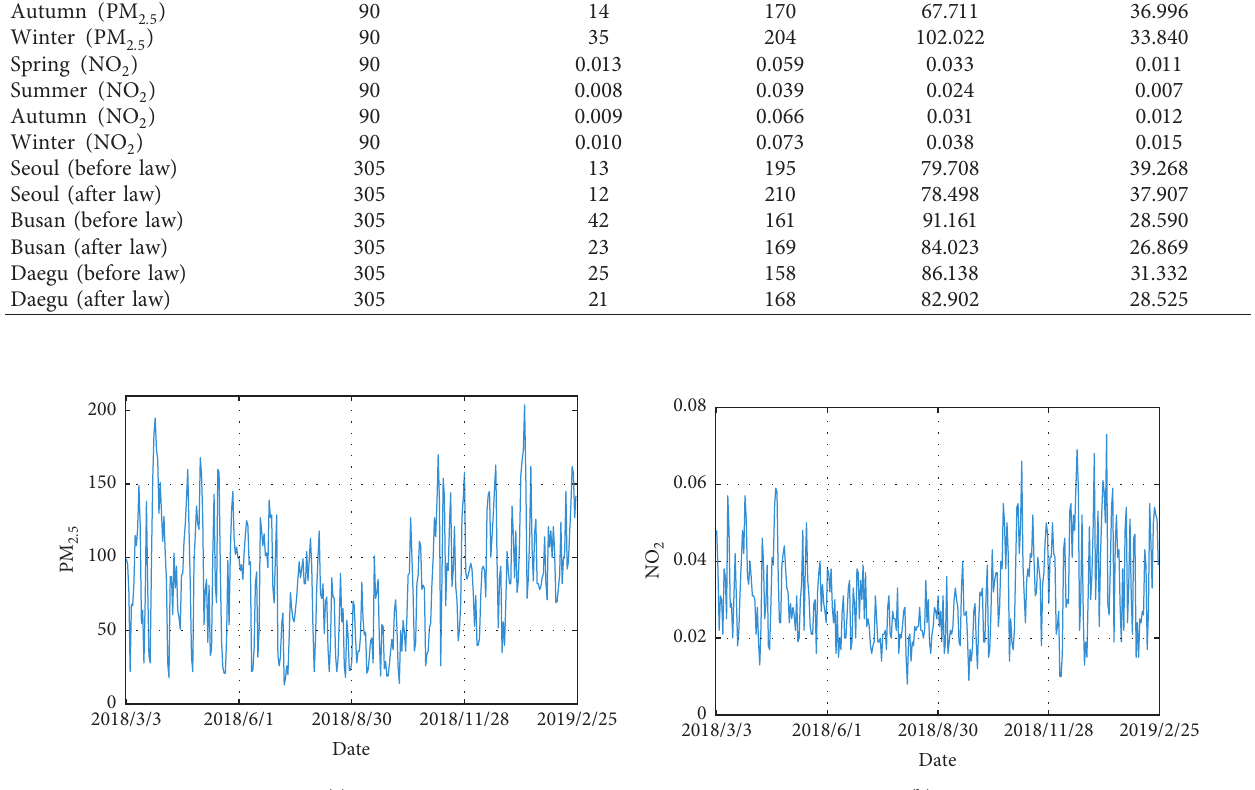
Figure 1: Time series of (a) PM